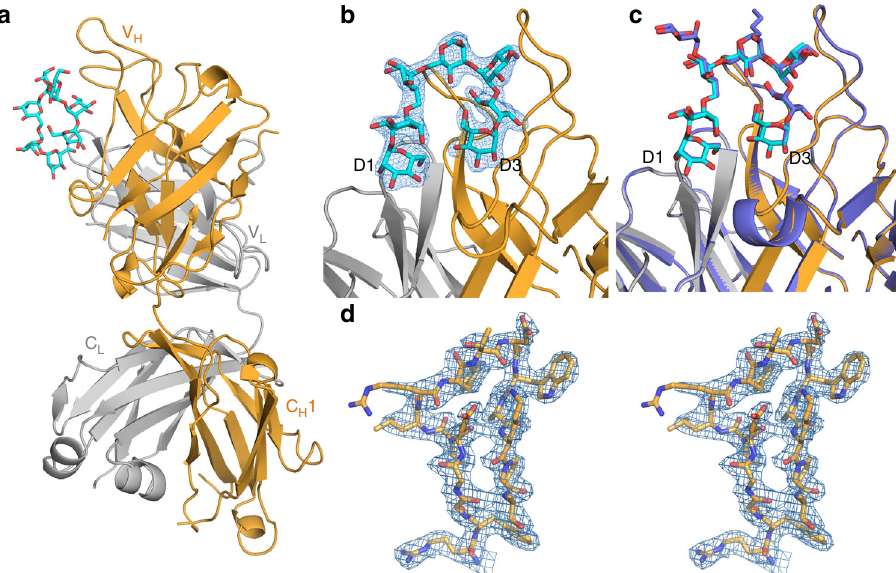
Fig. 5 Crystal structure of PGT128 with an oligomannose mimetic. a Overview of the crystal structure of PGT128 bound to NIT68A. The Fab heavy and light chains are shown in orange and gray, respectively. The NIT68A glycoside is shown in ball-and-stick representation, with carbons in cyan and oxygens in red. b View of the NIT68A-binding site of PGT128, with 2Fo-Fc electron density (at σ = 1) for the mimetic shown as a mesh. c View of the NIT68A-binding site of PGT128, colored as above, with the structure of PGT128 in complex with Man 9 (PDB 3TV3) superimposed and shown in lavender ribbon and ball- and-stick representation for the respective Fab and ligand. d Stereo view of the PGT128 Fab CDRH3, showing the 2Fo-Fc electron density contoured at σ = 1 for residues 94 – 101 (shown as